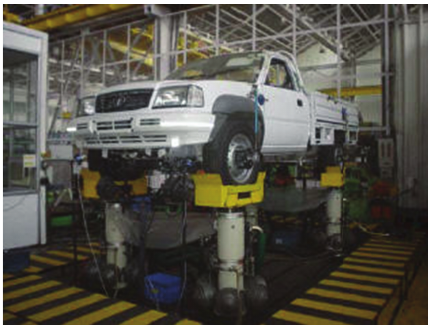
Figure 2: Four-post hydraulic simulator, from Awate et al.